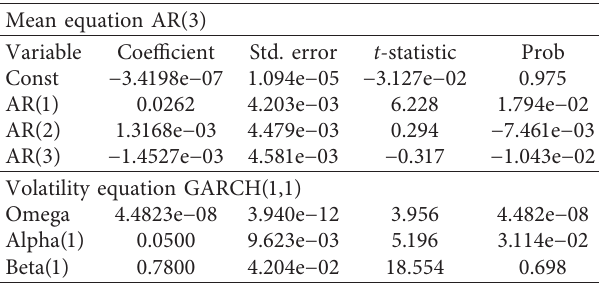
Table 5: The fitting results of the GARCH(1,1) model in the active stage of HFT.